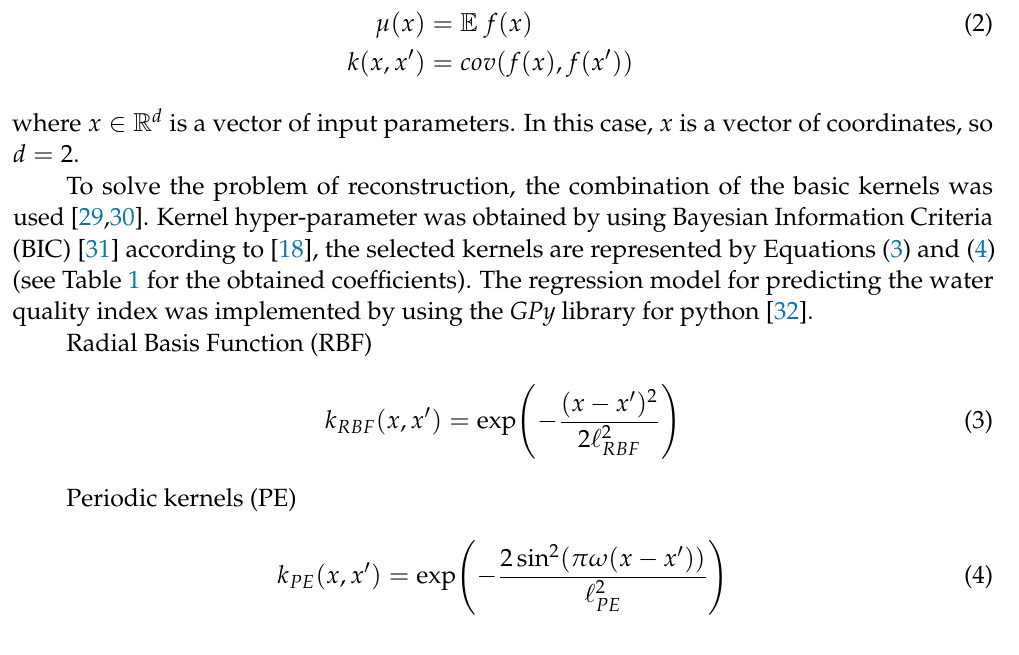
Table 1. Optimal kernel parameters for Gaussian Process Regression obtained by using Bayesian Information Criteria